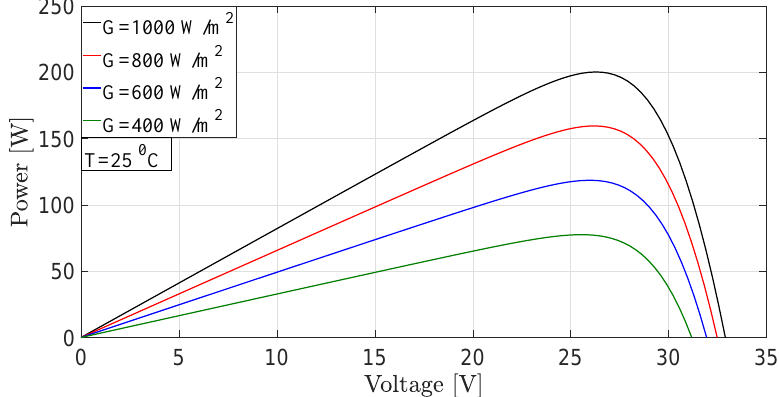
Figure 3. P–V characteristics of the PV source for various radiation values.